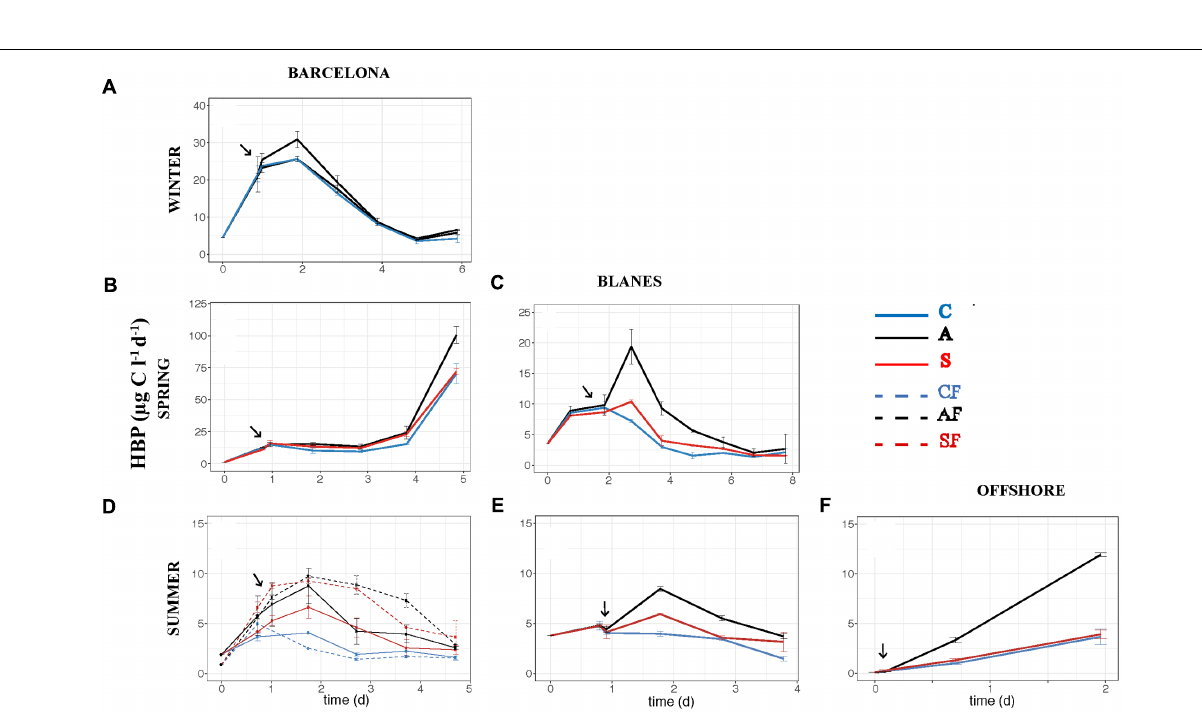
Frontiers in Microbiology |